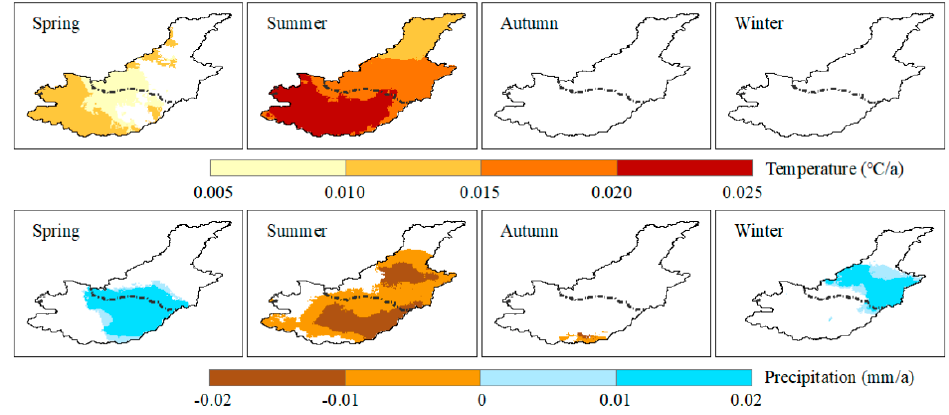
Figure 4. Spatial distribution of the change trends ( p < 0.05) of the seasonal temperature (upper) and precipitation (lower) over the Selenga-Baikal Basin from 1982 to 2015.